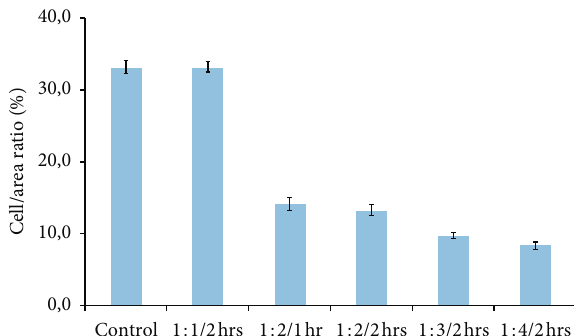
Figure 8: Percentage comparison of cell/area of the independent experiments (the data show results of independent replicates in each